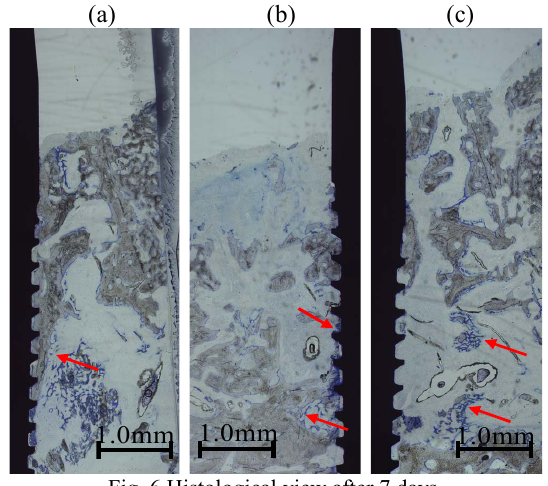
Fig. 6 Histological view after 7